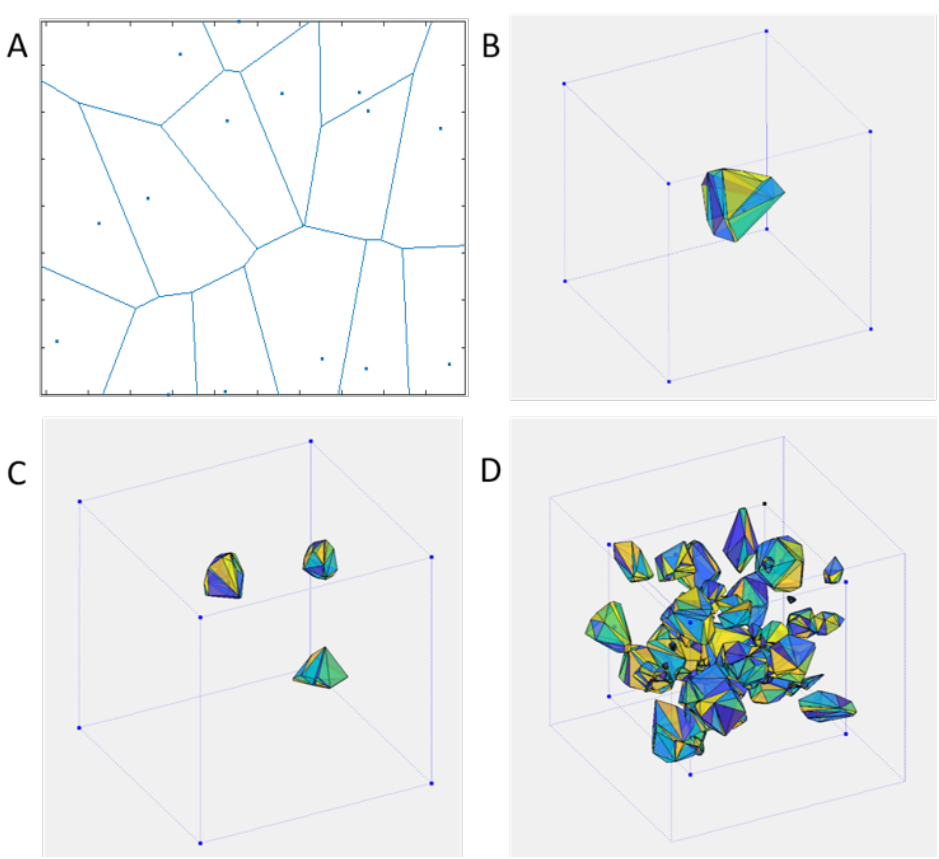
Figure 1. ( A ) 2D Voronoi cells, ( B ) 3D Voronoi cell, ( C ) Voronoi cells as pores produced by randomly generated seed points, ( D ) differently sized Voronoi cells produced iteratively.